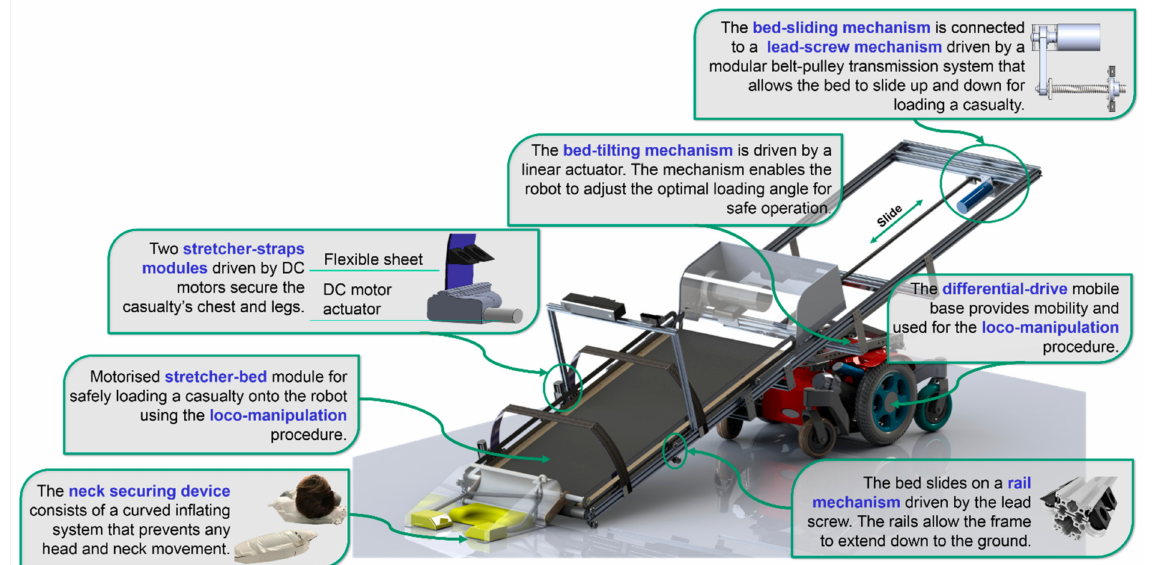
Figure 9. The ResQbot 2.0 design comprises seven main novel components: A differential-drive mobile base; a stretcher bed tilting mechanism; a stretcher bed sliding mechanism; a motorised stretcher bed conveyor module; a pair of motorised stretcher strap modules; and a neck securing device